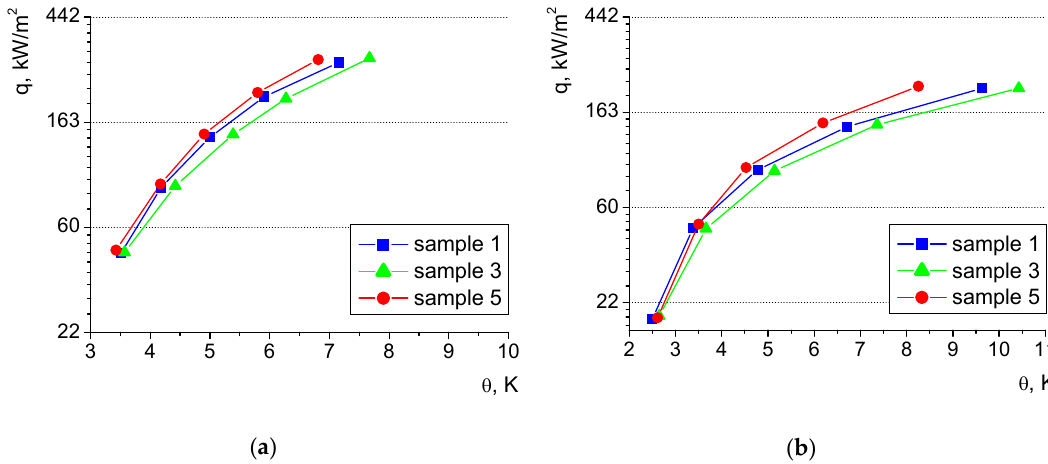
Figure 10. Boiling curves of samples of various ratio of surface area textured with laser to the total surface area (groove depth, 0.55 mm); ( a ) distilled water, ( b ) ethyl alcohol.